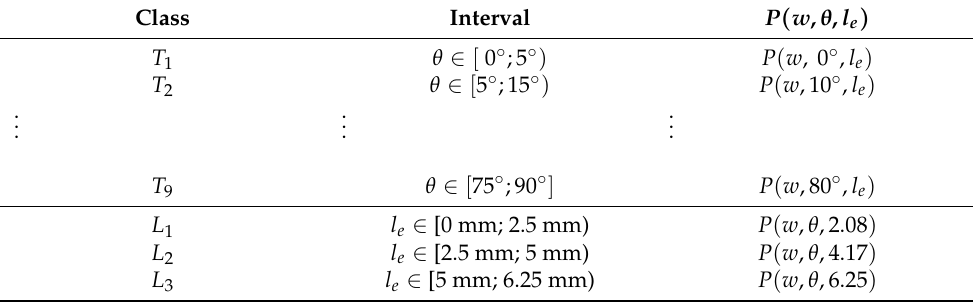
Table 2. Binning of embedded length l e and inclination angle θ